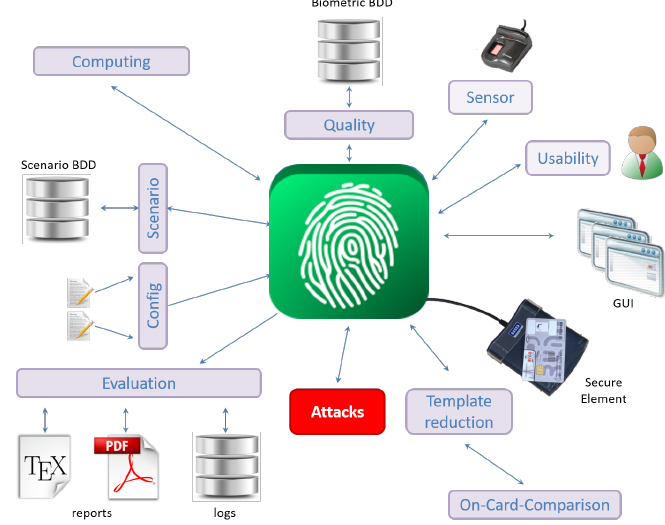
Figure 4. General diagram of the EvaBio platform (defined in